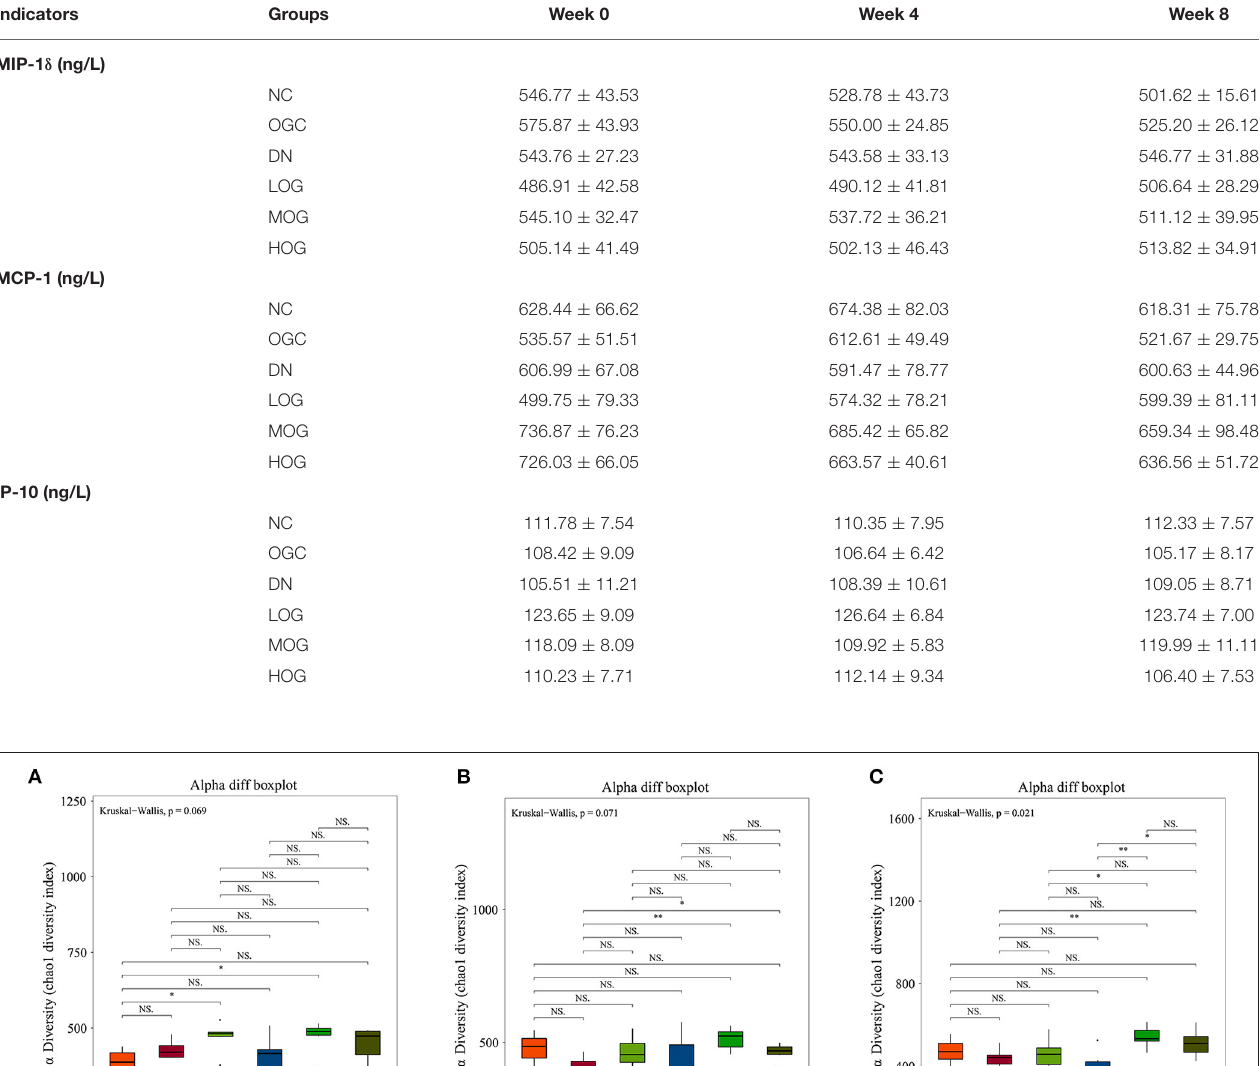
TABLE 3 | Inflammatory changes in the urine of the rats in each group ( n = 10). Indicators Groups